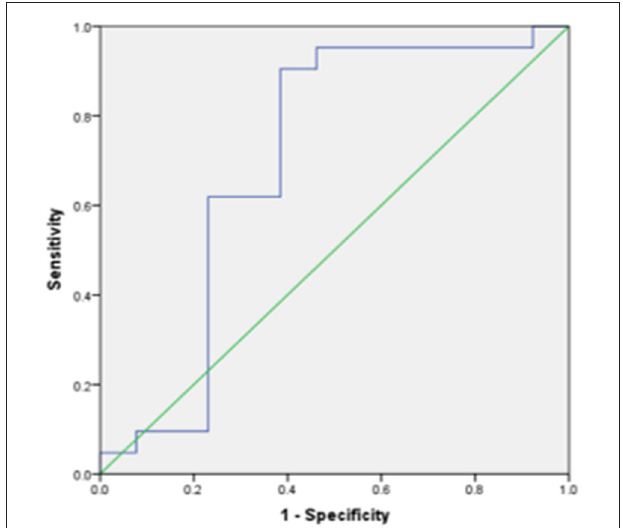
FIGURE 8 | The ROC curve of skewness in the ADC histogram between the endometrial mesenchymal sarcoma group and degenerative hysteromyoma